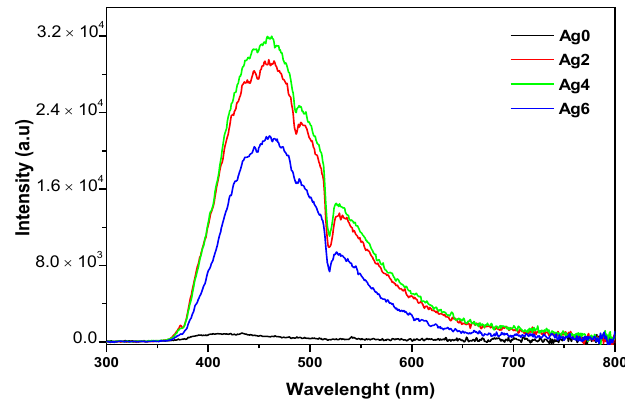
Figure 3. Emission spectra of the investigated glasses upon 325 nm excitation.